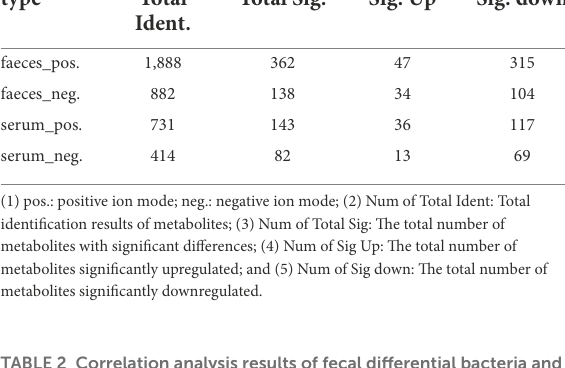
TABLE 1 Metabolite differential screening results. Sample type